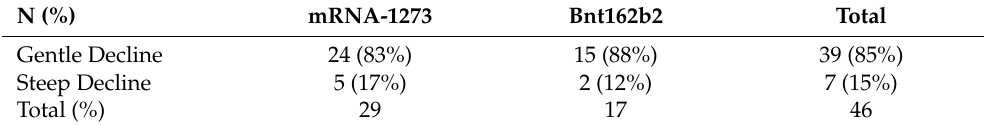
Table 4. Slope Decline Categories in Subjects Reporting Clinical COVID Illness prior to Vaccination.